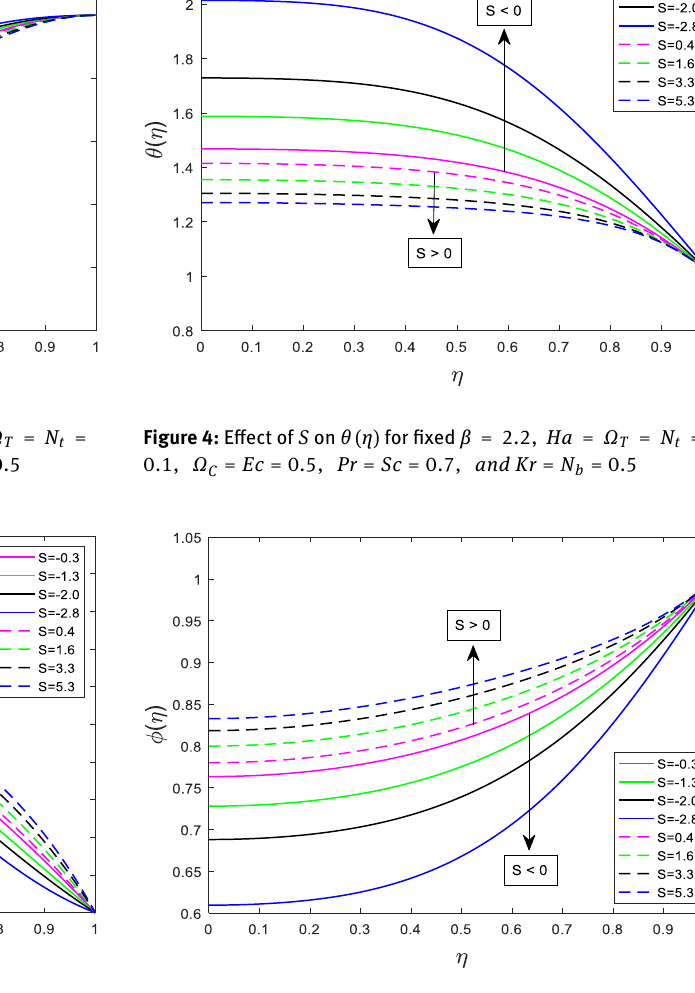
Figure 3: Effect of S on F (cid:48) ( η ) for fixed β = 2.2, Ha = Ω T = N t = 0.1, Ω = Ec = 0.5, Pr = Sc = 0.7, and Kr = N C